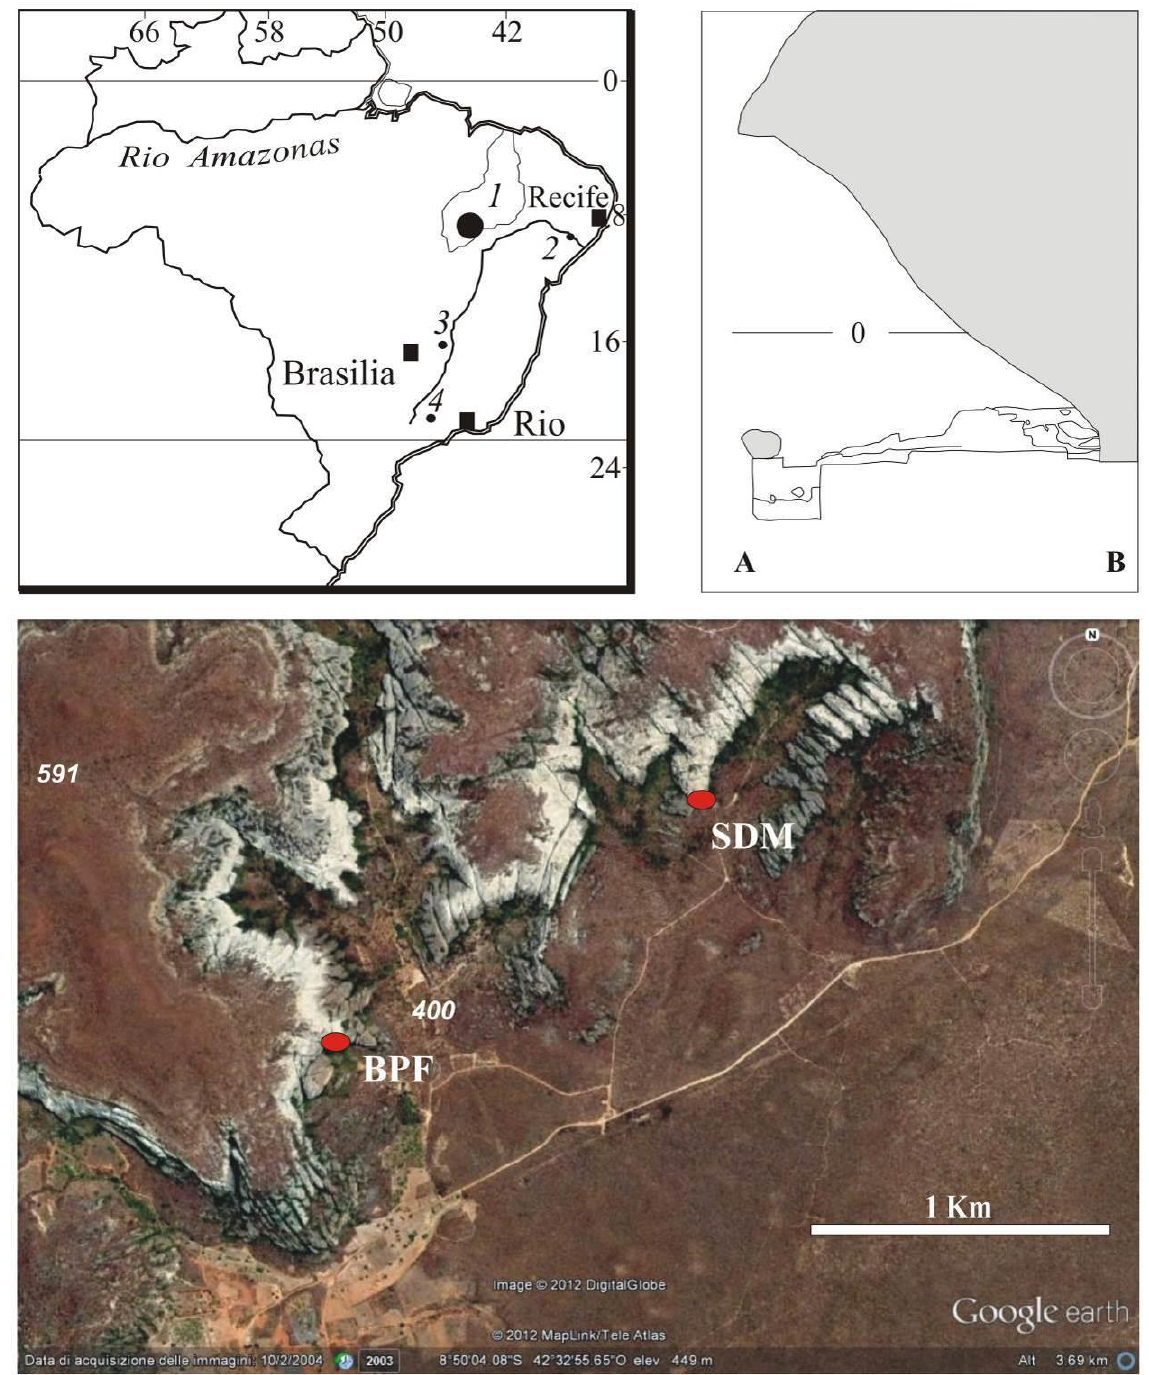
Figure 1. Position of sites: Sitio Do Meio (SDM) and Boqueirão da Pedra Furada (BPF.). Aerial image from Google Earth